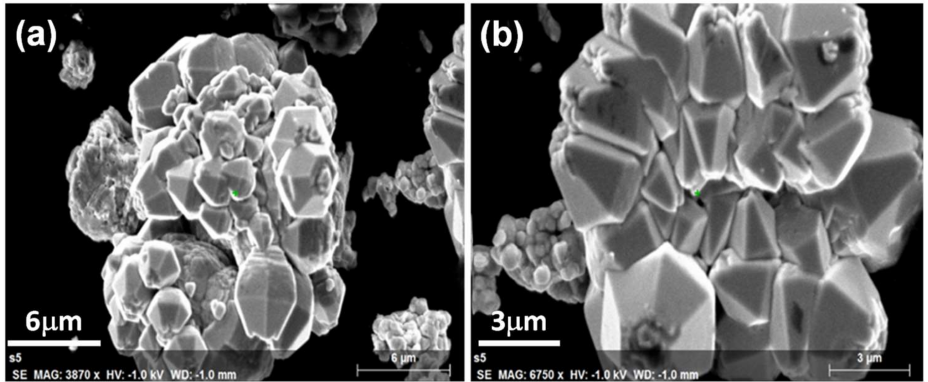
Figure 5. FE-SEM images of the as-synthesized ZnO nanocrystals in ( a ) low and ( b ) high magnification.